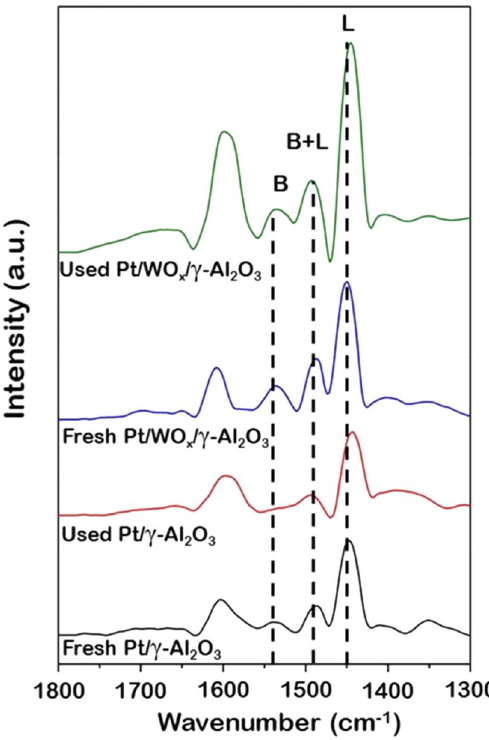
Figure 3. FTIR of pyridine adsorbed on fresh and reused Pt/γ-Al 2 O 3 and Pt/WO x /γ-Al 2 O 3 catalysts, where L and B represent Lewis and Brønsted acid.